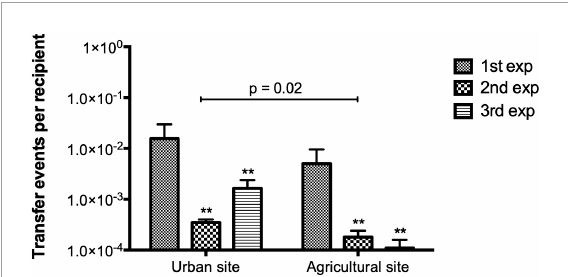
FIGURE1 Transfer frequencies (TFs) obtained from conjugation experiments in LB media using aquatic donor communities from urban and agricultural areas of the La Paz River basin and E. coli CV601 (recipient). Bars represent mean values obtained from three independent conjugation experiments. Error bars represent the standard deviation of the mean from the two mating replicates included in each independent experiment. A higher number of transfer events per recipient was obtained using bacterial donors from the urban site (Mann-Whitney U Test, p = 0.02). For both sampling sites, TFs varied significantly between independent experiments. Asterisks (**) show the significantly between difference from the first independent experiment (1st exp) by Brown-Forsythe ANOVA p = 0.03, post hoc Tukey test. There was no significant difference in TF between the second and third independent